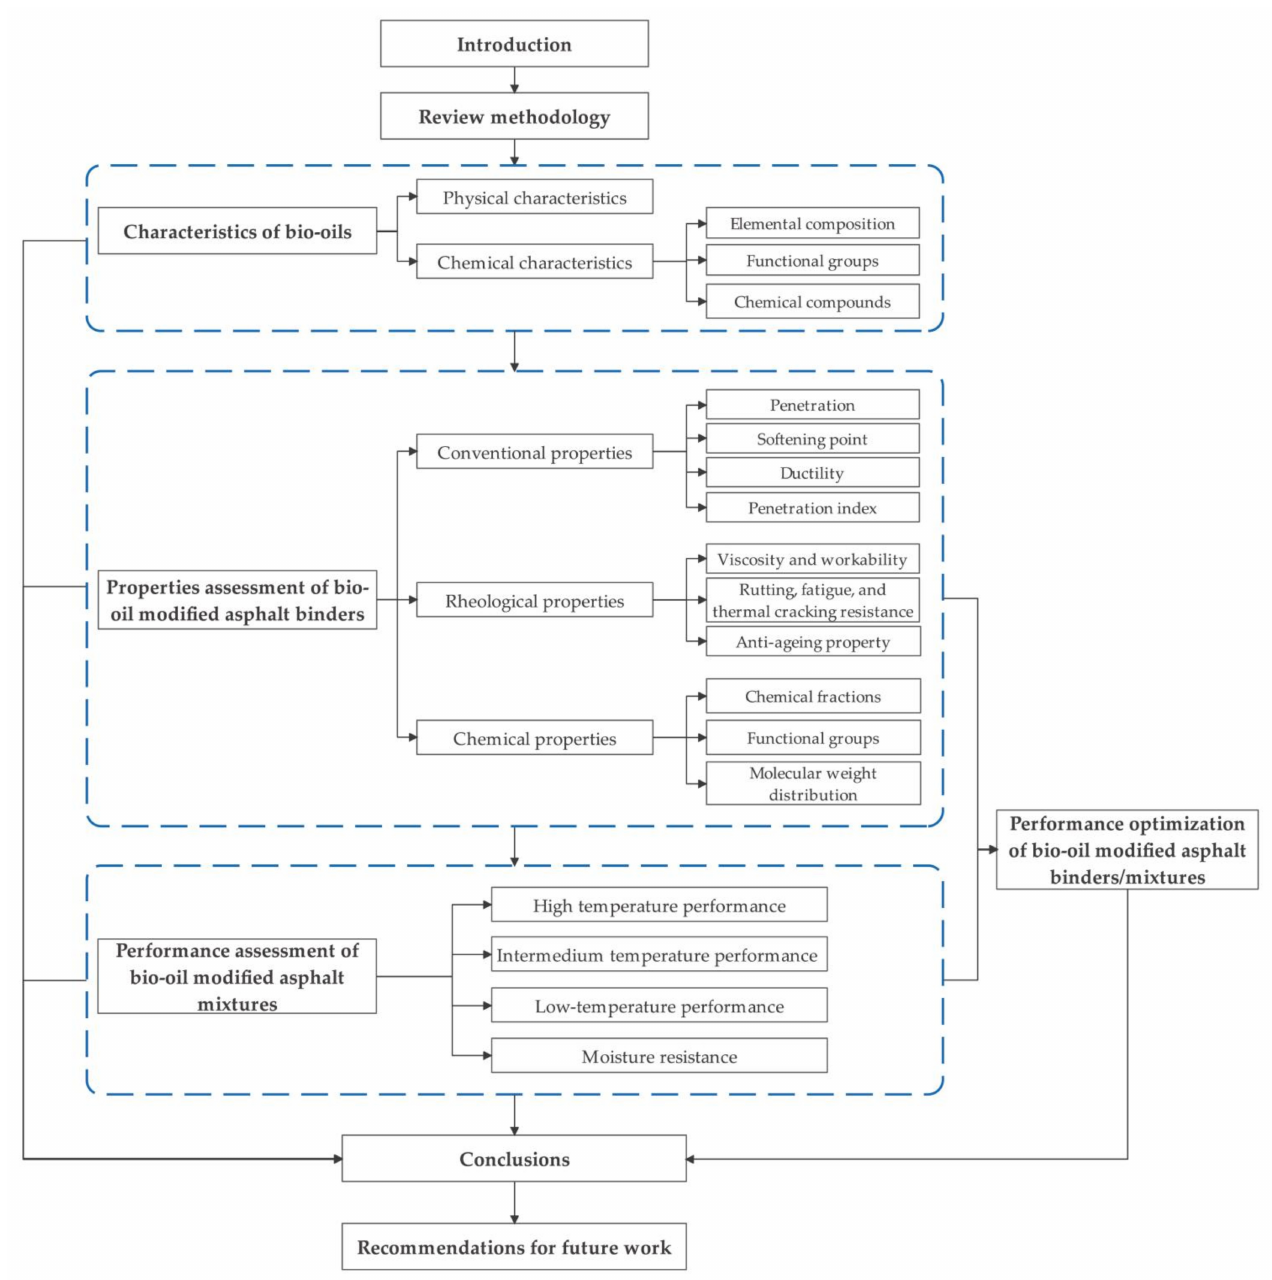
Figure 1. The flowchart of this